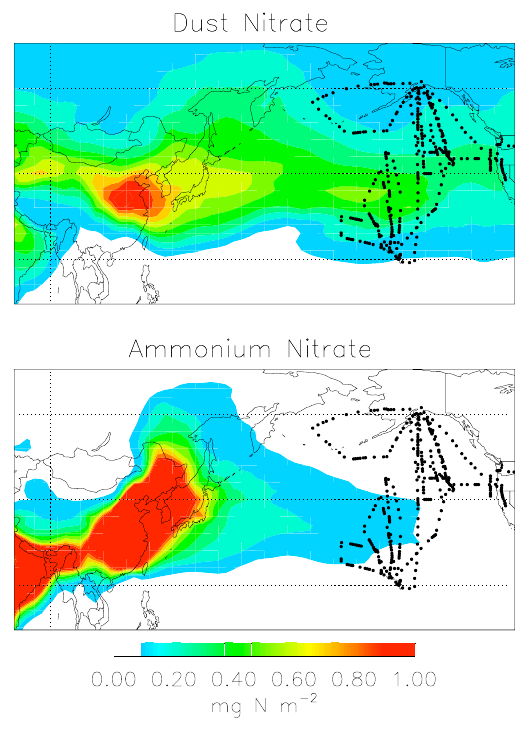
Fig. 6. Mean simulated column concentrations of dust nitrate and ammonium nitrate for the INTEX-B period (21 April–11 May 2006). Results are from the simulation including acid uptake. Black symbols show the aircraft flight